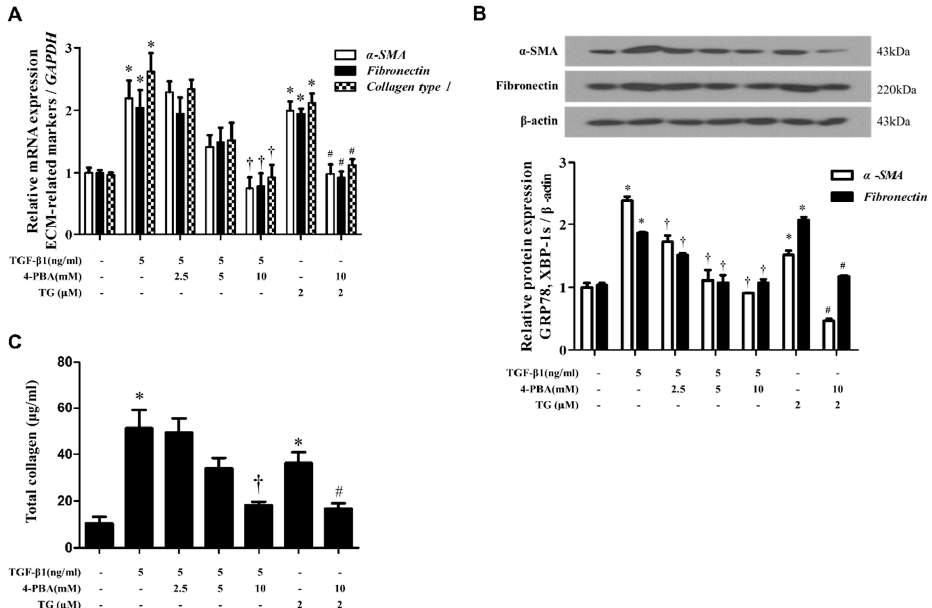
PBA (2.5 ‒ 10 mM) for 1 h and were stimulated with TGF- β 1 (5 ng/mL) for 24 h. Relative mRNA